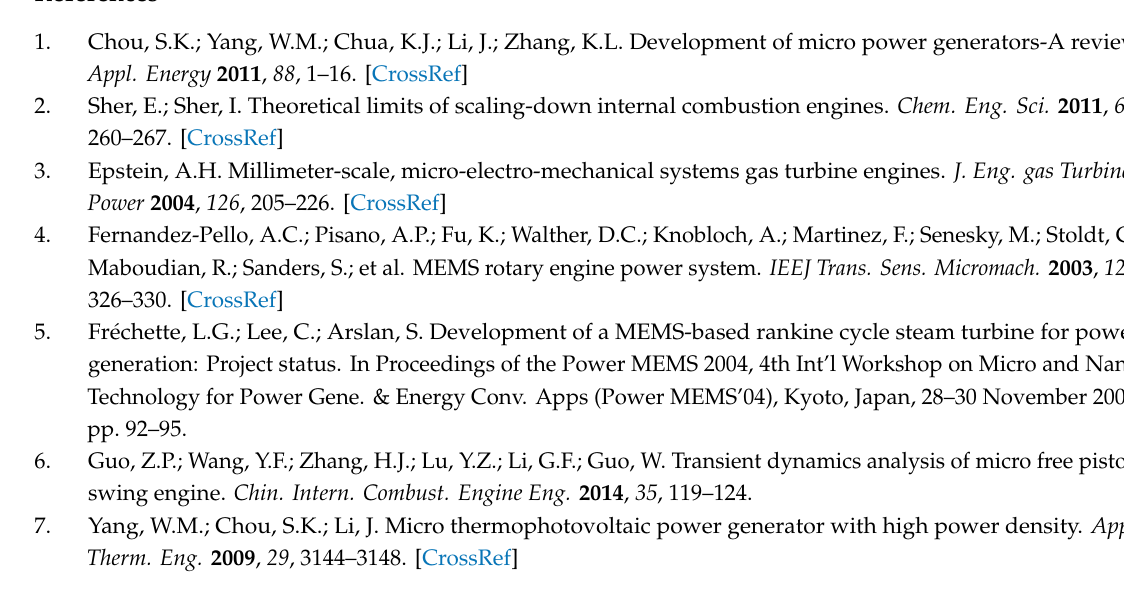
Table S1: Methanol-nitromethane mixed fuel combustion chemical reaction